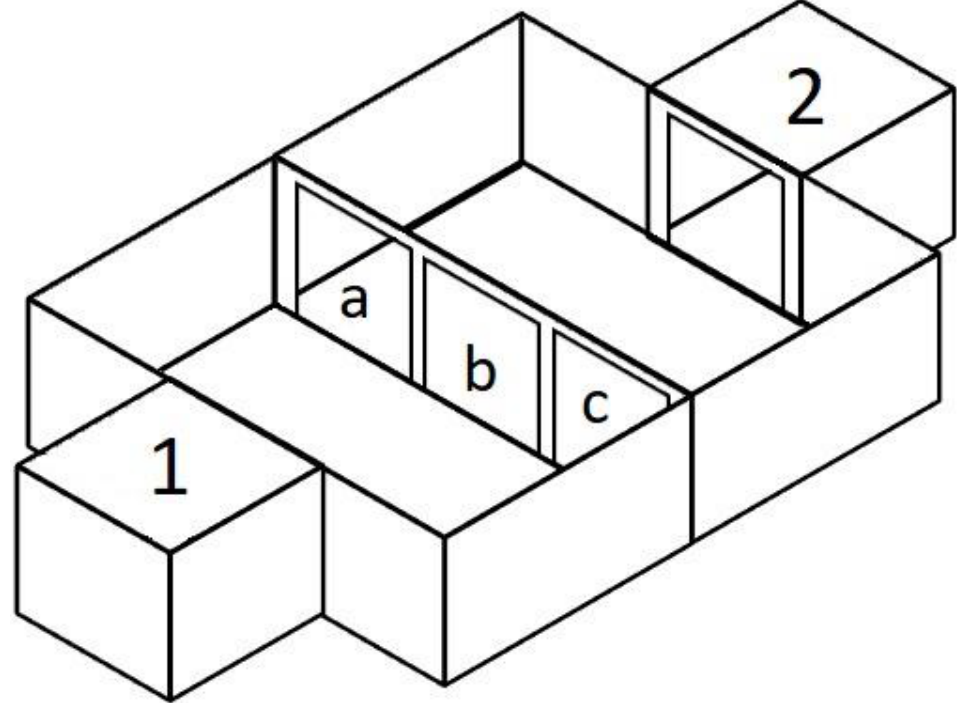
Figure 1. The experimental setup: 1—launch box; 2—finish box with bait; a, b, c—holes in the partition.